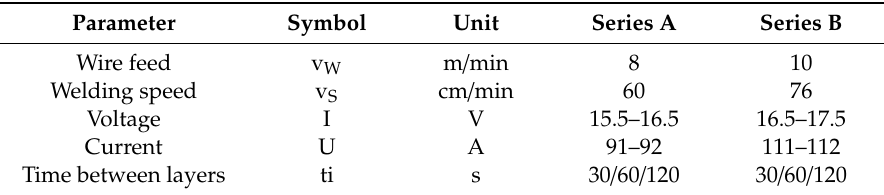
Table 2. Welding parameters for processing of